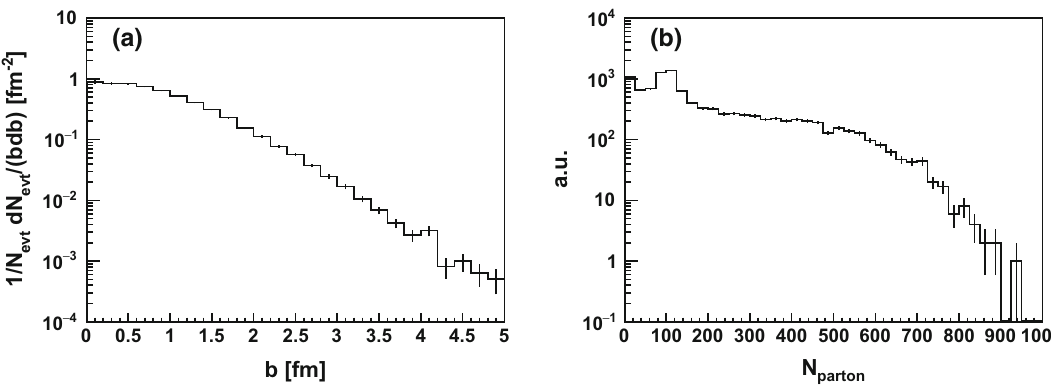
Fig. 2 Normalized impact parameter b distribution from PYTHIA/Angantyr ( a ) and the parton number distributions after string melting ( b ) for √ s = 13 TeV pp collisions at